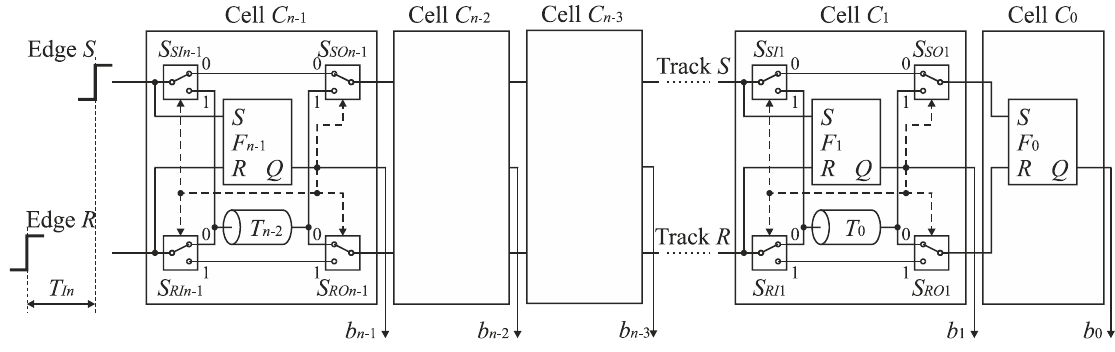
Figure 16. Architecture of n -bit feedforward SA-TDC with single set of delay lines.